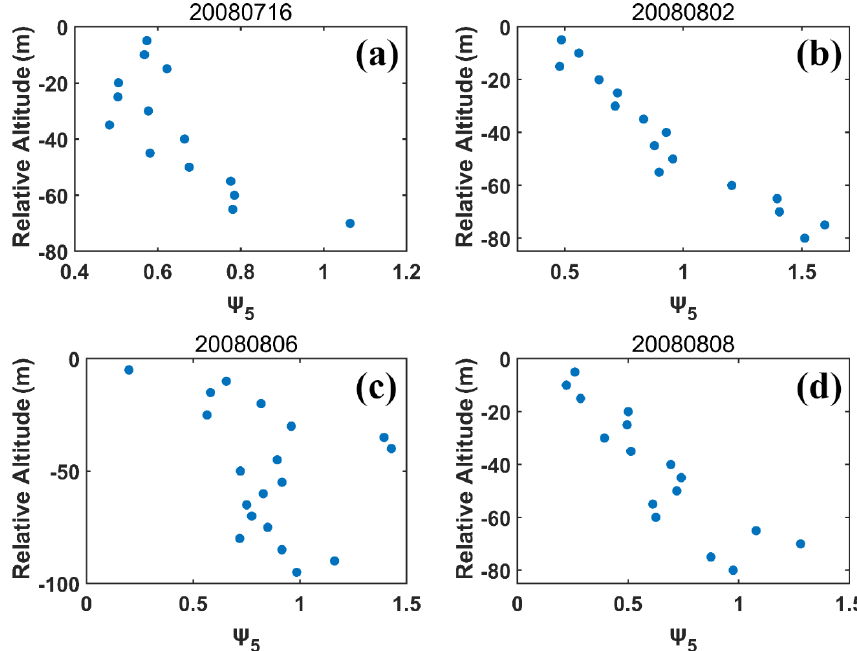
Figure 6. Height dependence of the newly defined homogeneous mixing degree ( ψ 5 ) on (a) 16 July 2008, (b) 2 August 2008, (c) 6 August 2008 and (d) 8 August 2008. The relative altitude on the y axis equal to 0 represents the cloud tops.